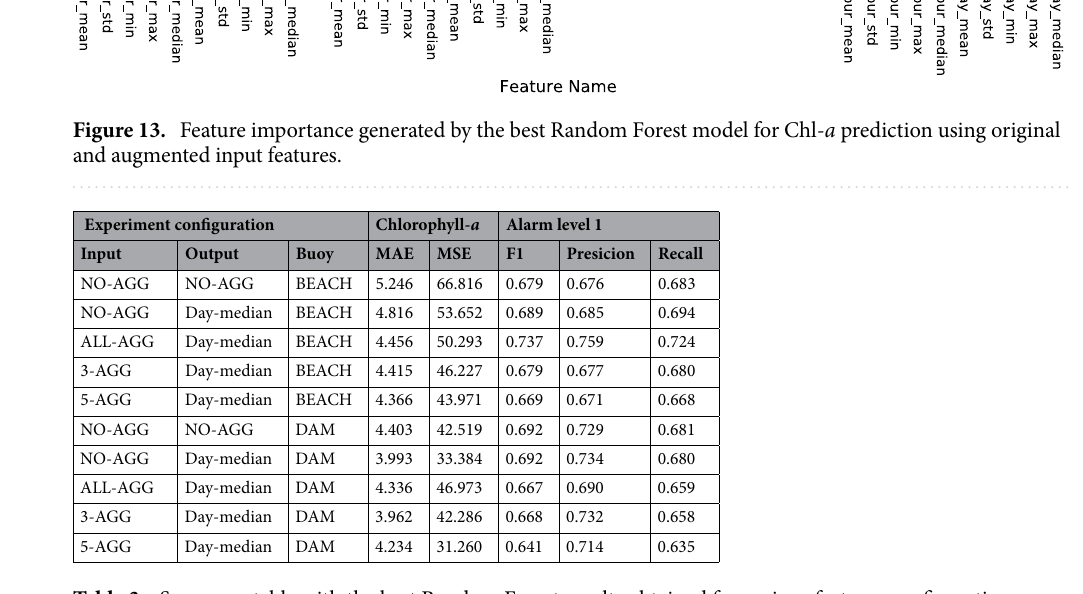
Table 3. Summary table with the best Random Forest results obtained for various features configurations (input and output aggregations) and buoys. Mean absolute error (MAE) and mean squared error (MSE) are Chlorophyll- a regression metrics. F1-score, Precision and Recall are Alarm level 1 classification metrics.